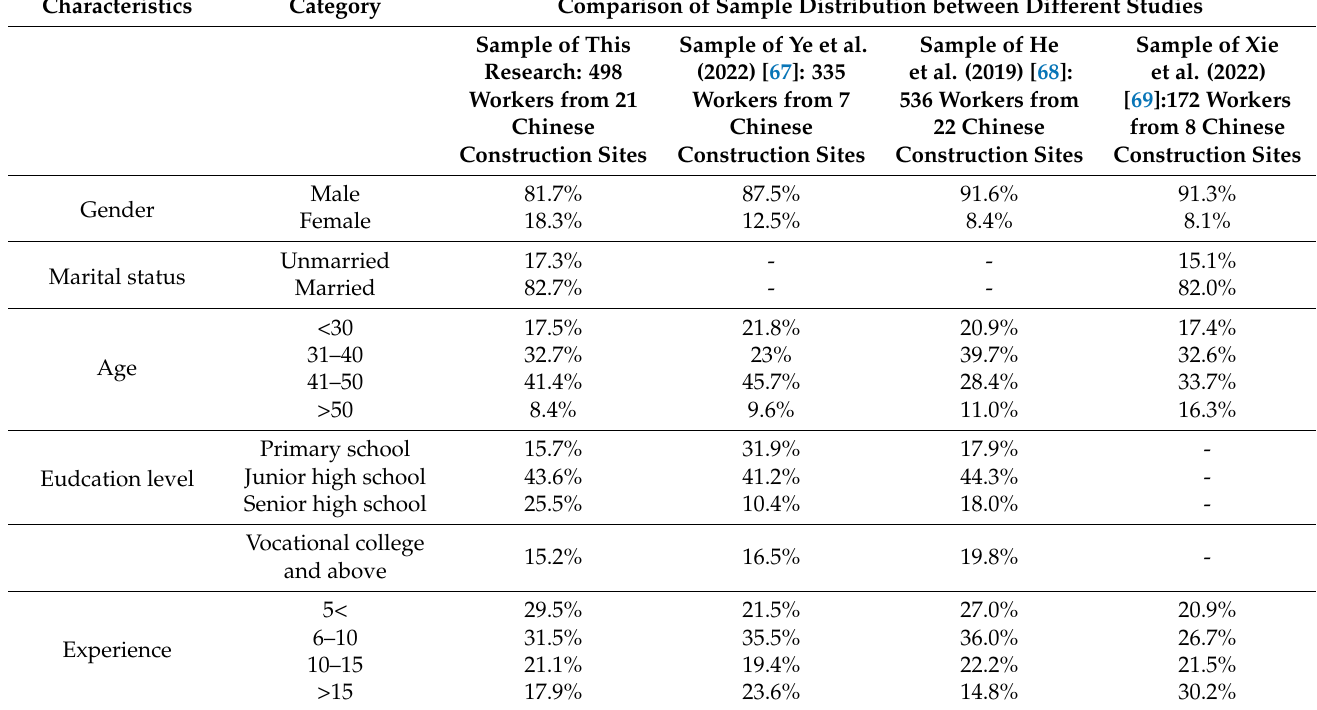
Table 1. The demographic characteristics of respondents involved in this research and the comparison with other studies. Characteristics Comparison of Sample Distribution between Different